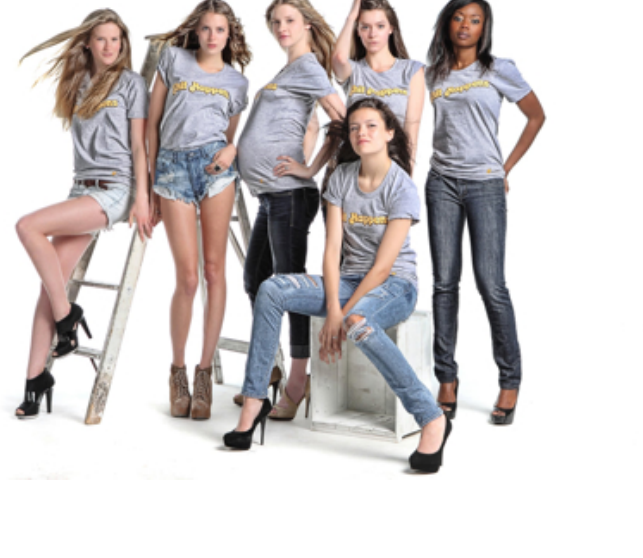
Figure 2. Image from HD Around the Globe campaign featuring models wearing the campaign